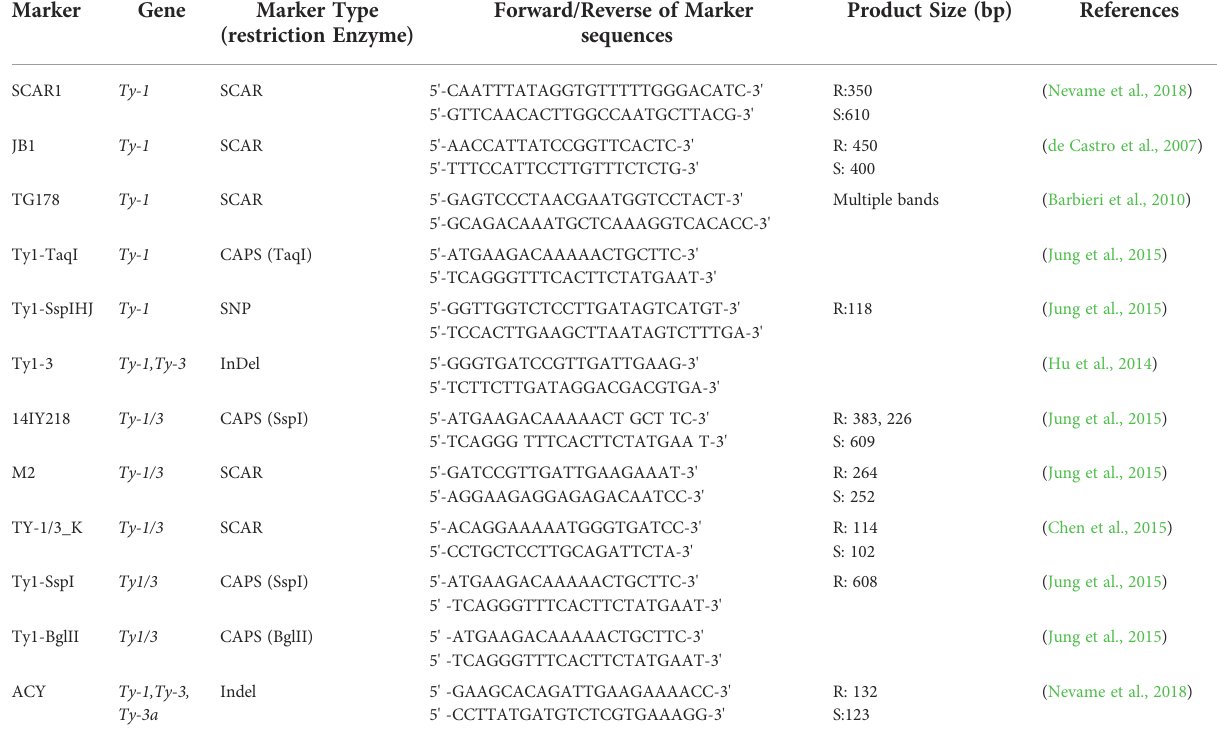
TABLE 2 Genetic markers assisted breeding to TYLCV resistance. Marker Gene Marker Type (restriction